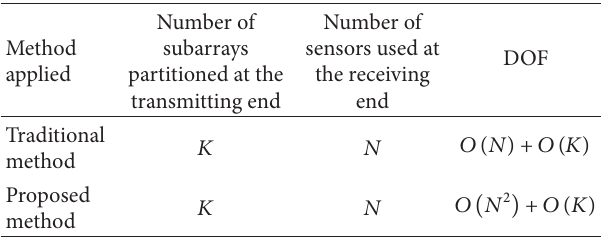
Table 1: Comparative DOF between the traditional method and the proposed